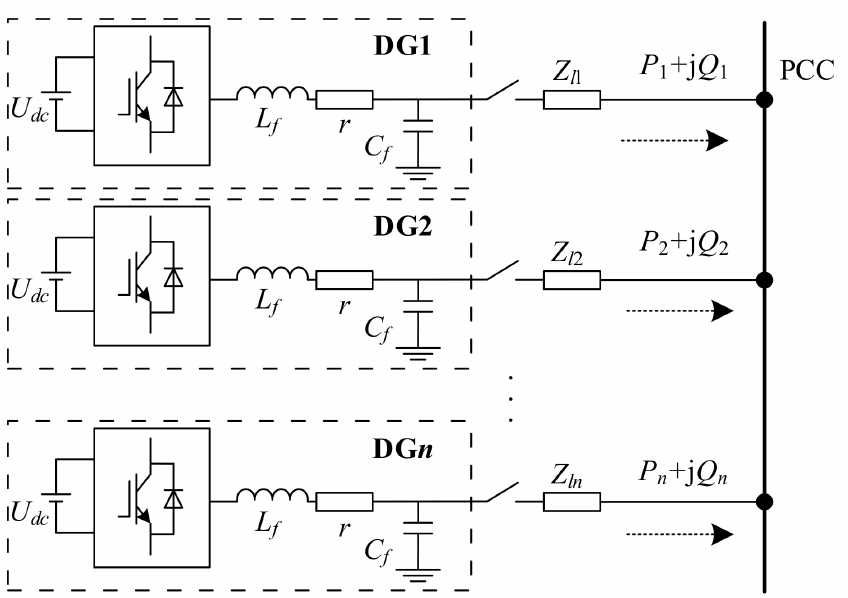
Figure 1. Configuration of the islanded microgrid.